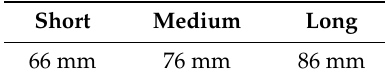
Table 2. Sleeve lengths used in analysis.